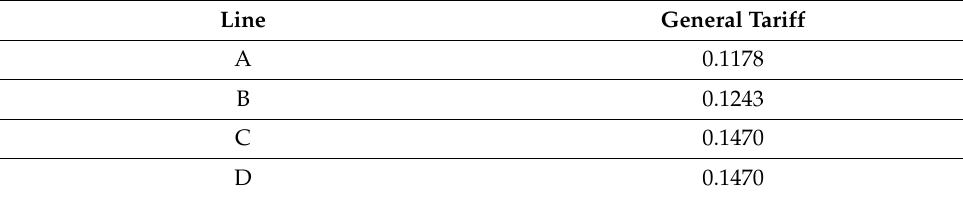
Table 8. General tariff (in EUR) per